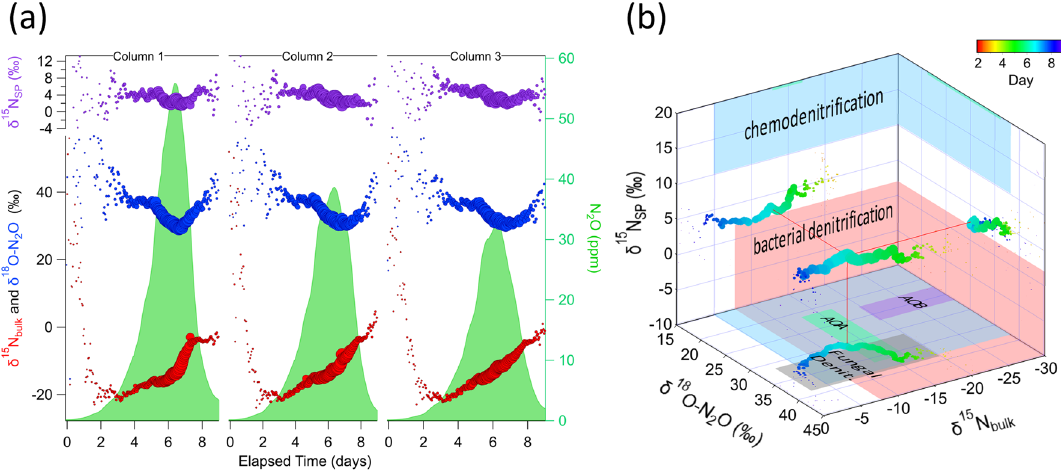
Figure 3. N 2 O pulse responses to N addition were accompanied by reproducible trends in N 2 O isotopes. ( a ) N 2 O concentration (green shading) pulses and shifts in bulk δ 15 N bulk (red), δ 18 O-N 2 O (blue), and δ 15 N SP (purple) in replicate soil columns (Experiment 1). Marker size reflects N 2 O concentration, and precision of N 2 O isotope signatures increased with N 2 O concentration. ( b ) Projection of bulk δ 15 N bulk (x-axis), δ 18 O-N 2 O (y-axis), and site preference (z-axis) probe measurements onto regions of known microbial N 2 O pathways. On the x–y axis AOA (green rectangle) and AOB (purple rectangle) refer to NH 3 nitrification from ammonia oxidizing archaea 56,72 and ammonia oxidizing bacteria 50,56,73 , respectively. Grey rectangle indicates fungal denitrification 74 . Uncertainties in isotopic values due to matrix effects and calibration drift are 5.0‰, 1.6‰, and 2.5‰ for δ 15 N bulk , δ 15 N SP, and δ 18 O-N 2 O